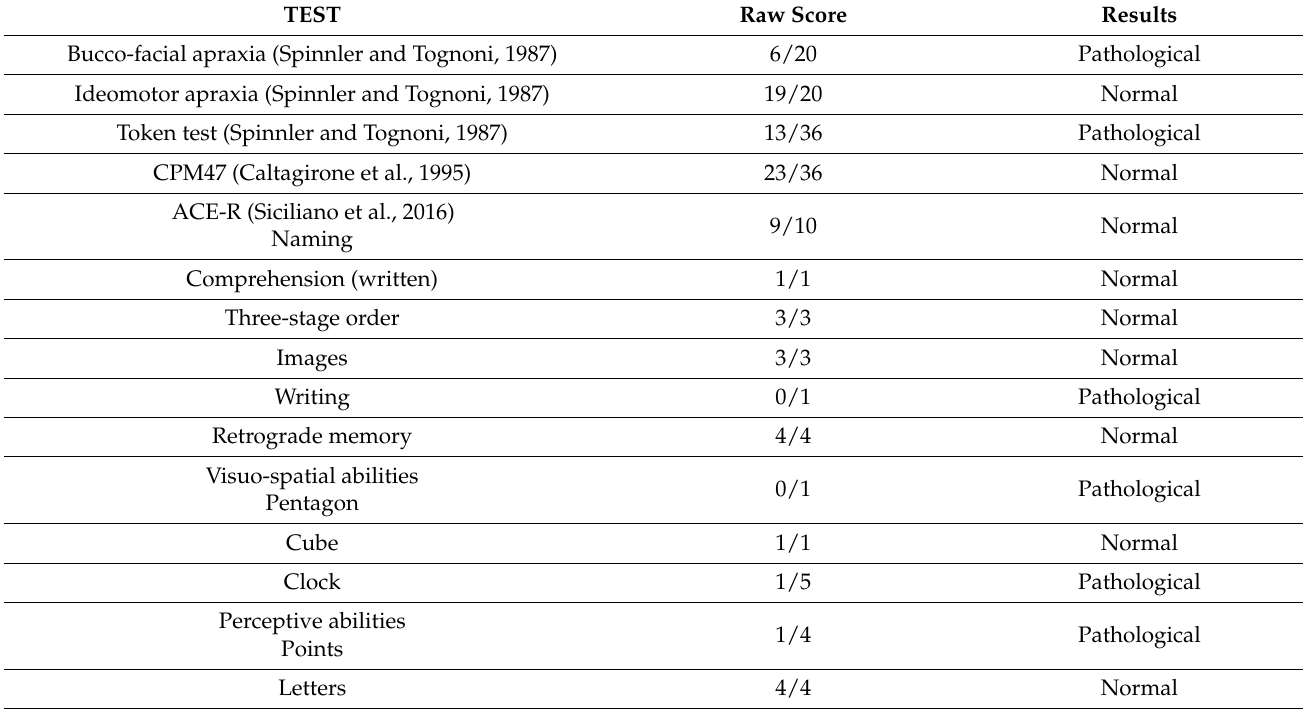
Table 1. Results of neuropsychological assessment in 2021. According to the equivalent score method, raw scores were classed into five ranges corresponding with five categories (0, 1, 2, 3, and 4). We considered pathologic an equivalent score of 0, which indicated a performance corresponding with the worst 5% of the normative